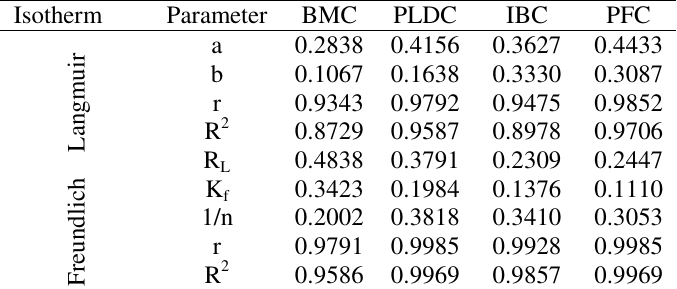
Table 2. Adsorption isotherm constants for the removal of